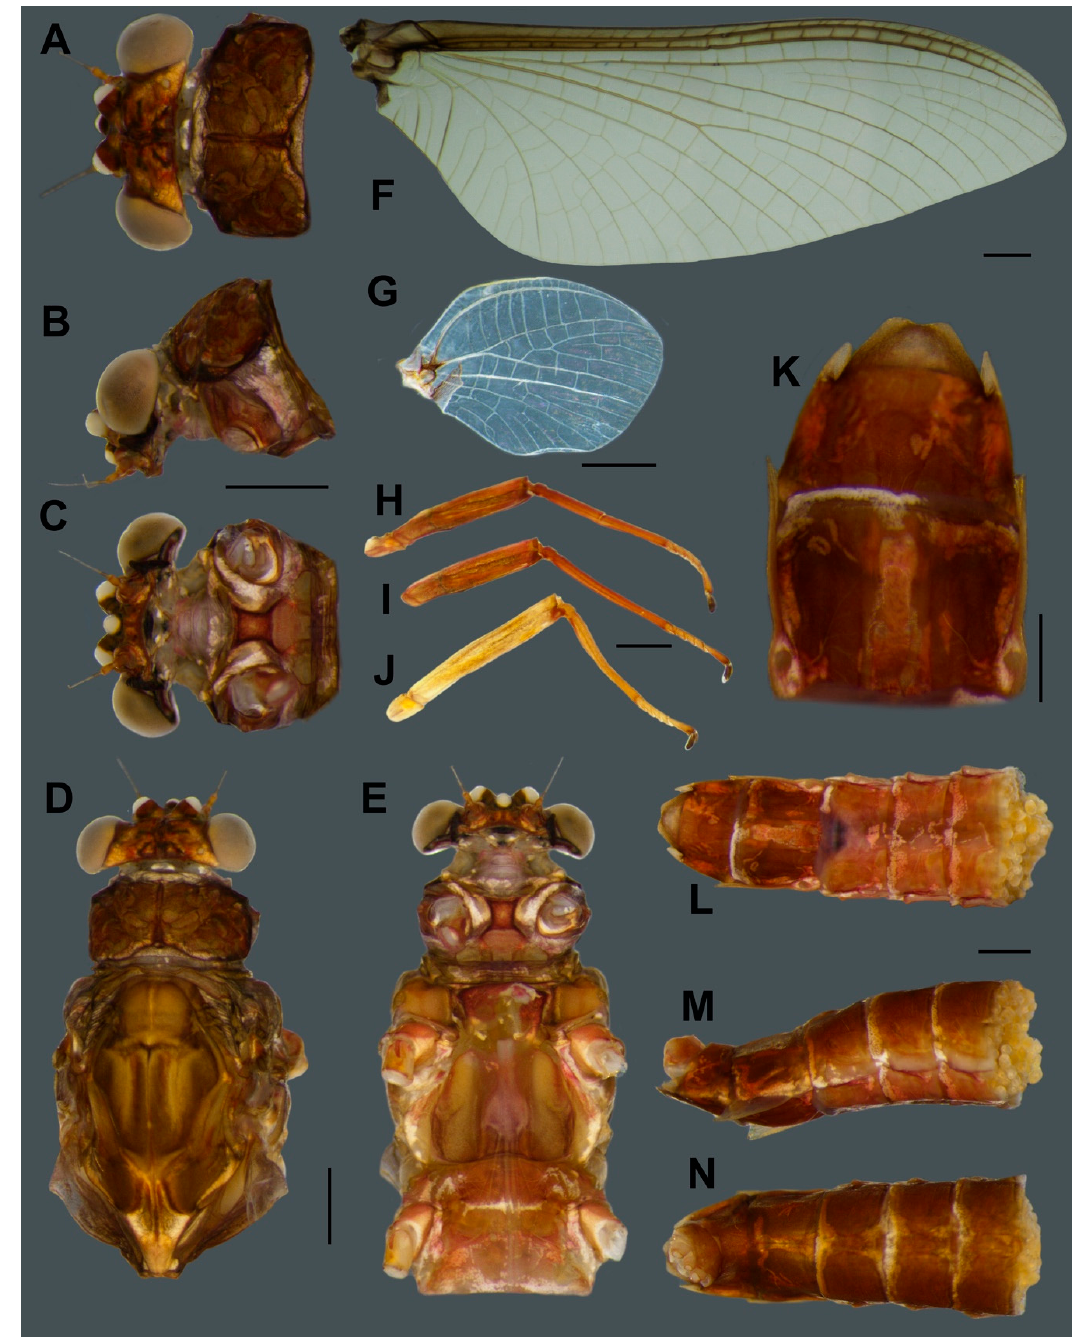
Figure 5. Female imago of Vietnamella nanensis sp. n. Dorsal ( A ), lateral ( B ) and ventral ( C ) views of head; dorsal ( D ) and ventral ( E ) views of thorax; ( F ) forewing; ( G ) hindwing; ( H ) foreleg; ( I ) middle leg; ( J ) hindleg; ( K ) ventral view of genitalia; ventral ( L ), lateral ( M ) and dorsal ( N ) views of abdomen. Scale bars: 1 mm.